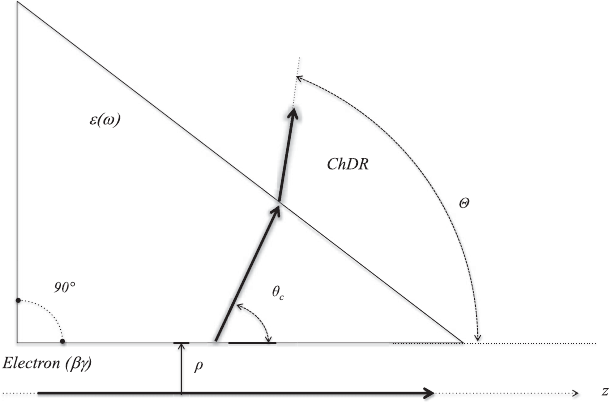
FIG. 1. Emission of Cherenkov diffraction radiation by an electron propagating at a distance ρ from the surface of a conical dielectric